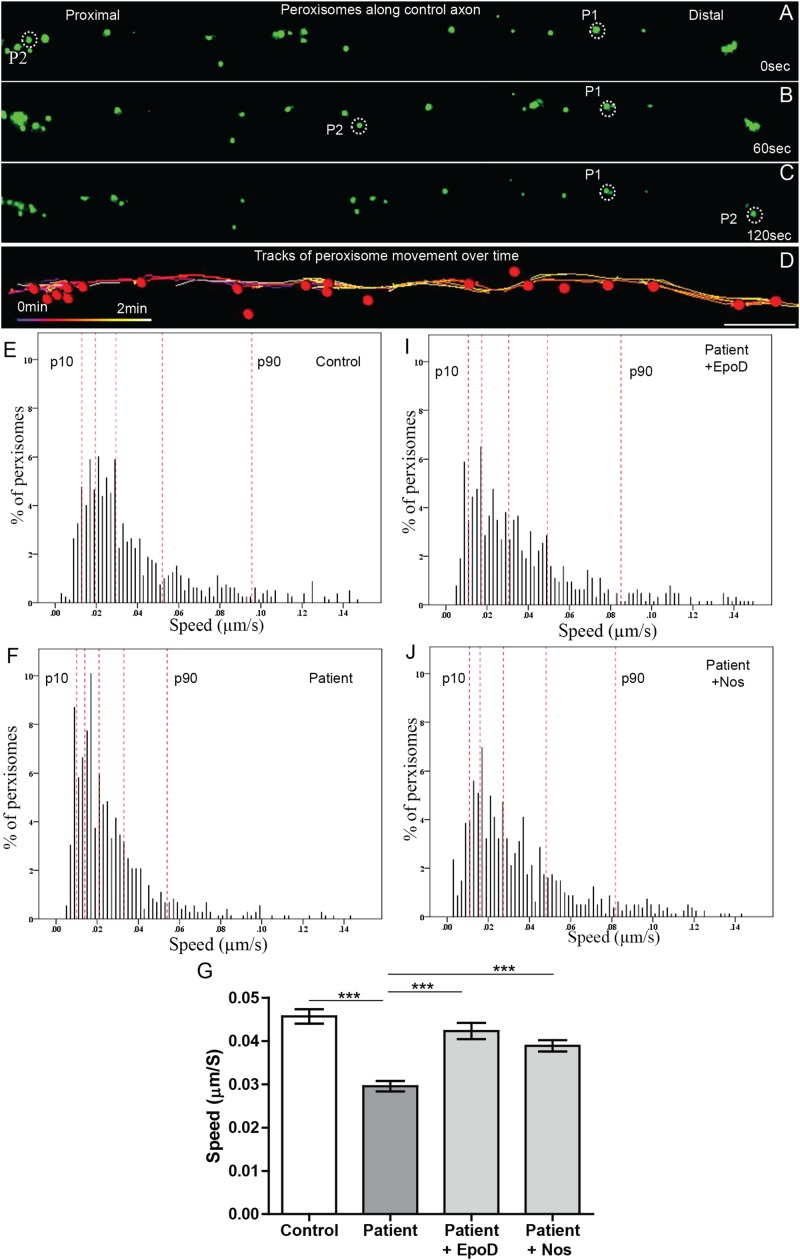
Peroxisome transport is reduced in SPAST patient axons and rescued by tubulin-binding drugs. (A,B,C) Time-lapse images of peroxisomes (green) in control axon at 0, 60, and 120 s (times shown on right). (D) Peroxisomes in A (red dots) and their paths of movement (colored lines) identified by the automated analysis software. Scale bar = 10 μm for all images. Frequency distributions of peroxisome speeds of: (E) untreated control group, (F) untreated patient group, (I) epothilone D-treated patient group, and (J) noscapine-treated patient group. The red dotted lines indicate the 10th, 25th, 50th, 75th, and 90th percentiles of the frequency distributions. (G) Means of peroxisome speed distributions. ***Different from the untreated patient group p < 0.0001.